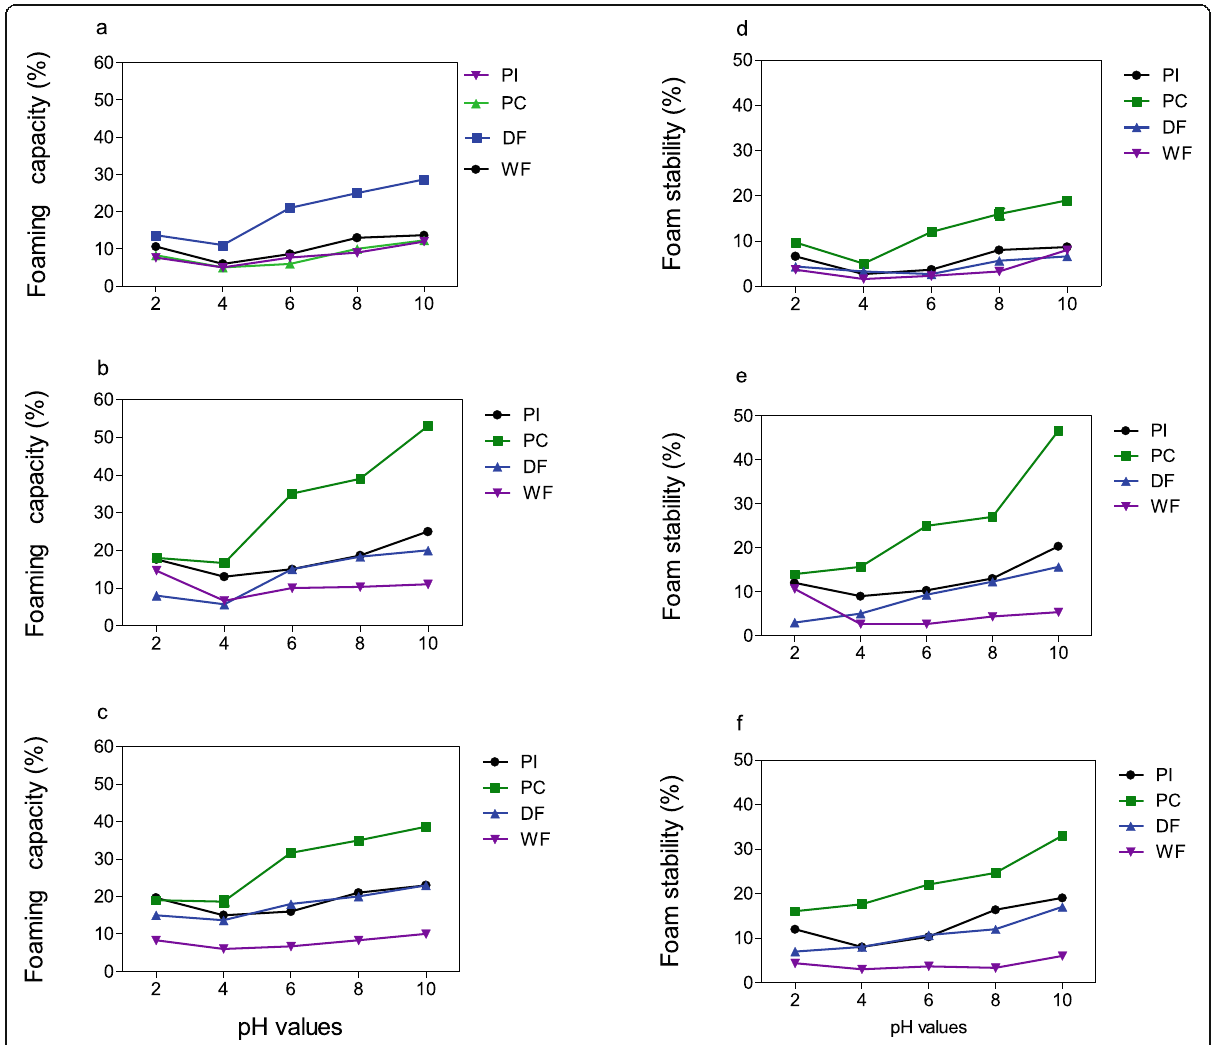
Fig. 3 Influence of NaCl concentrations and pH on the foaming capacity of okra seed samples at a no salt b 0.5 M NaCl concentration c 1.0 M NaCl concentration; and foaming stability at d no salt e 0.5 M NaCl concentration f 1.0 M NaCl